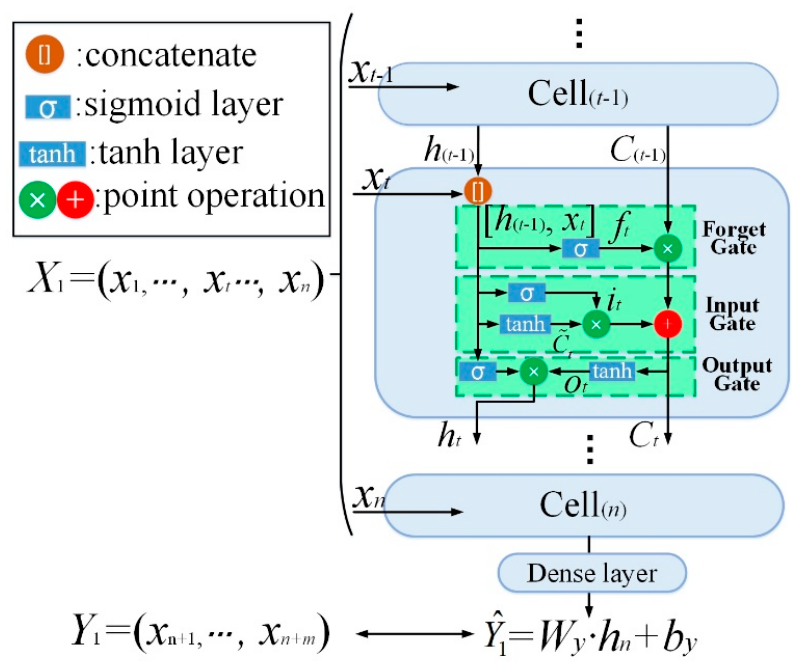
Figure 16. Structure of long short-term memory (LSTM) unit [117].